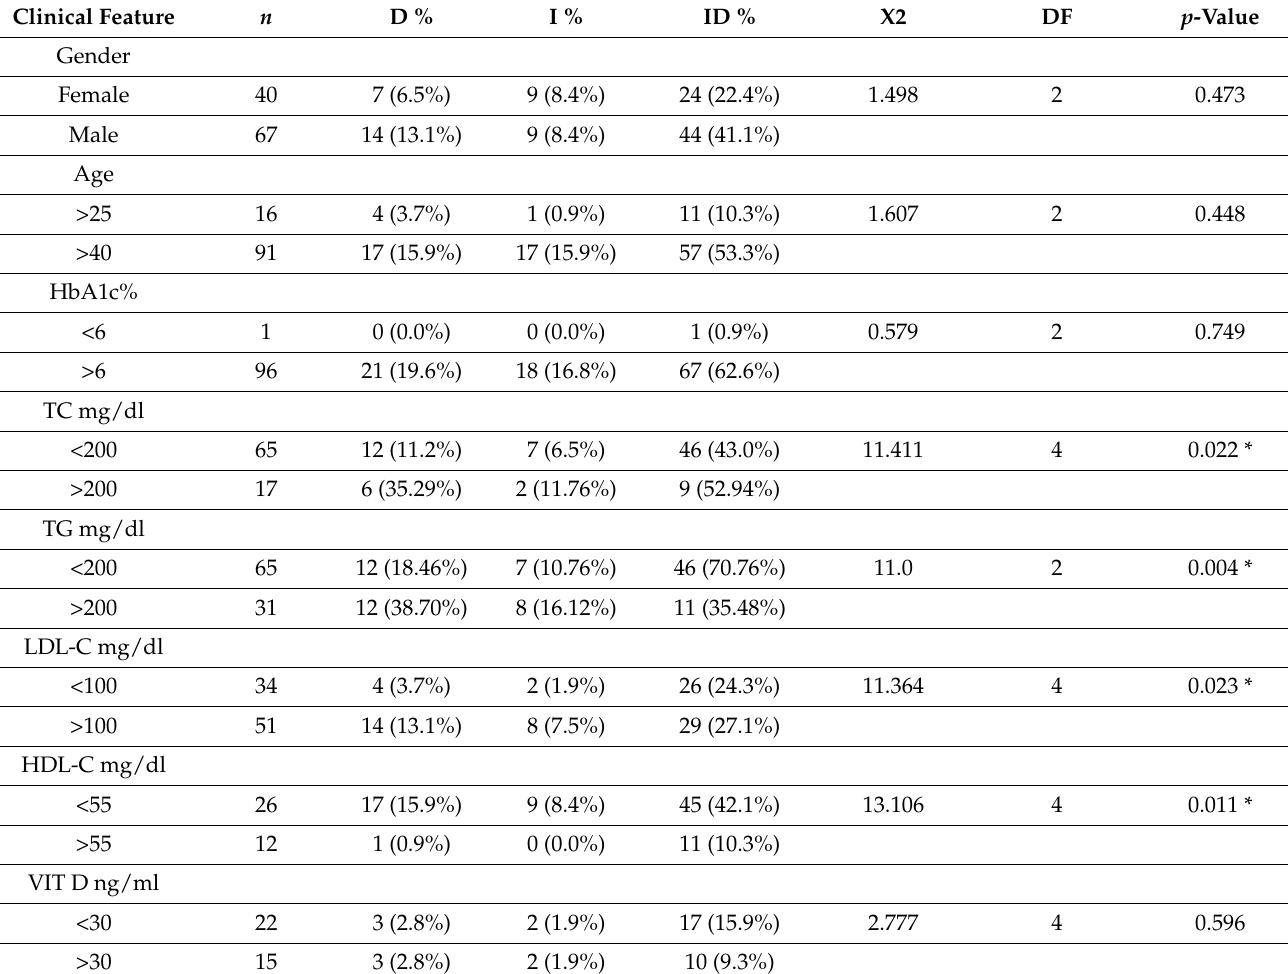
The gender and age are based on data for 107 cases. HbA1c% is based on data for 97 cases, cholesterol mg/dl—82 cases, LDL-C mg/dl—85 cases, HDL-C mg/dl—38 cases, and vitamin D ng/mL (VIT.D)—37